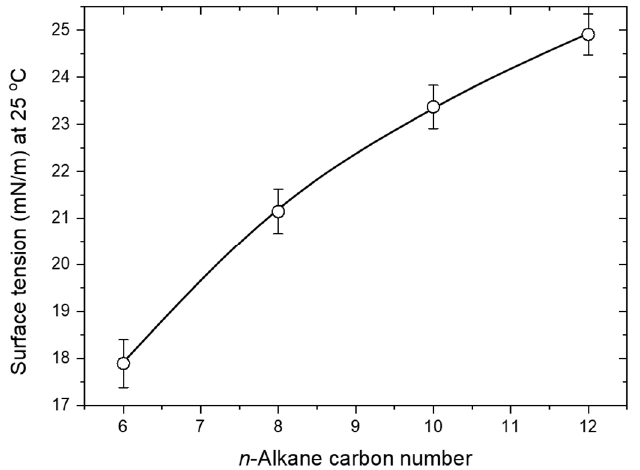
Figure 9. E ff ect of n -alkane chain length on surface tension. Values quoted at 25 ◦ C as the mean of data Figure 9. Effect of n -alkane chain length on surface tension. Values quoted at 25 °C as the mean of from Jasper and Kring [67] at 20 and 30 ◦ data from Jasper and Kring [67] at 20 and 30 °C.